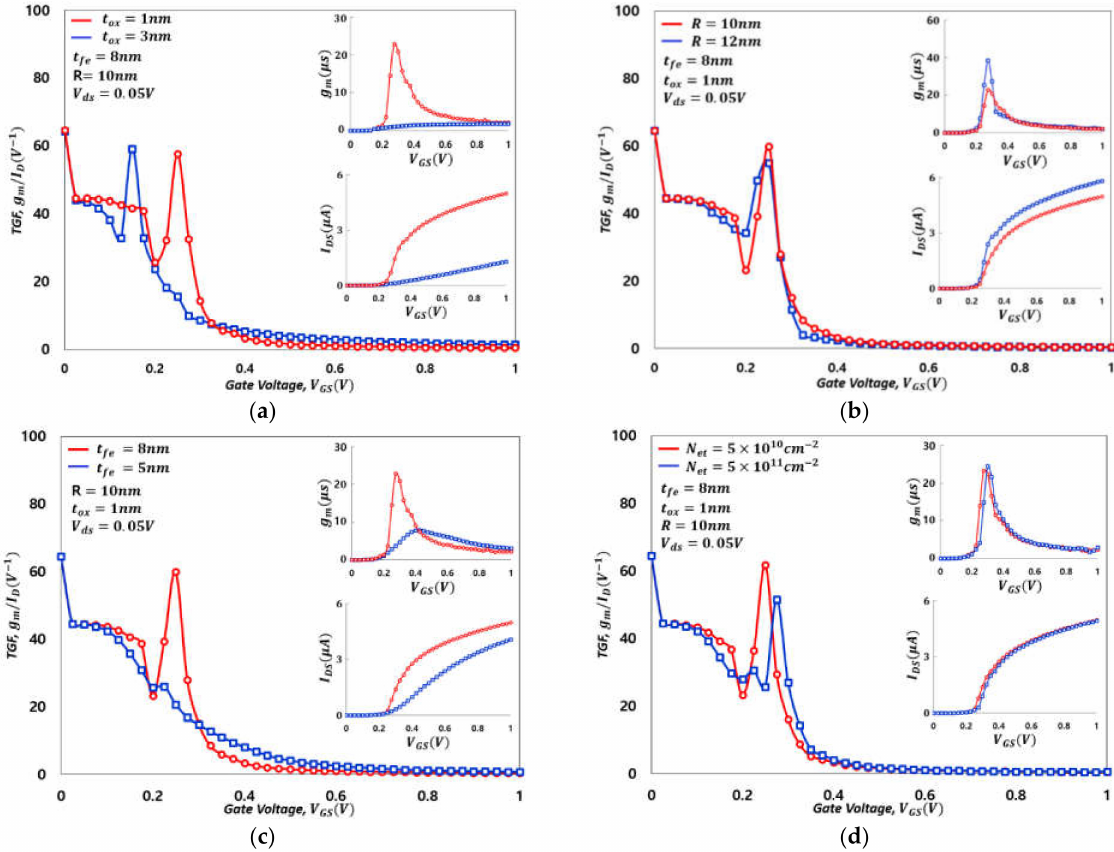
Figure 10. Characteristics of transconductance generation factor ( TGF ) for various geometries; ( a ) t ox , ( b ) R , ( c ) t fe , and trap density ( d ) N et